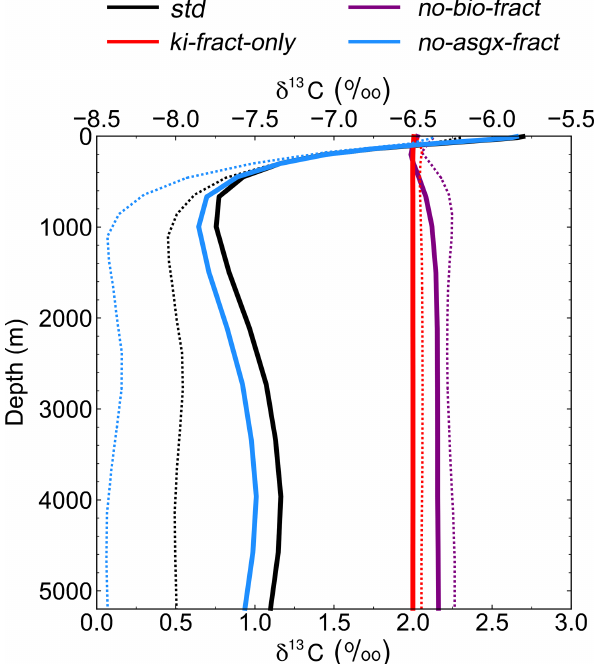
Figure 5. Depth profiles of globally averaged δ 13 C DIC at the end of the sensitivity experiment spin-up simulations (years 9900 to 10000). The std (black) and no-bio-fract (purple) simulations use the bottom axis, whilst the ki-fract-only (red) and no-asgx-fract (blue) simulations use the top axis. The dotted lines are the equiv- alent simulations conducted by Schmittner et al. (2013) with the UVic ESM: std (black) and no-bio (purple) on the bottom axis; ki- only (red) and const-gasx (blue) on the top